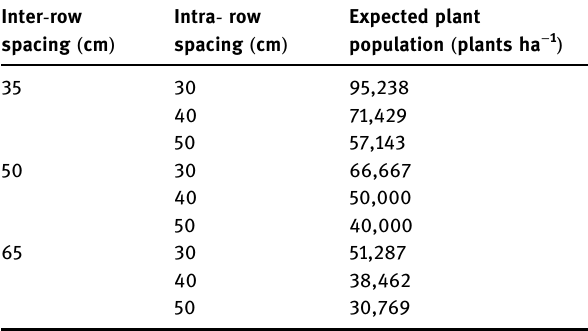
Table 1: Expected plant population in each respective inter - and intra - row spacing